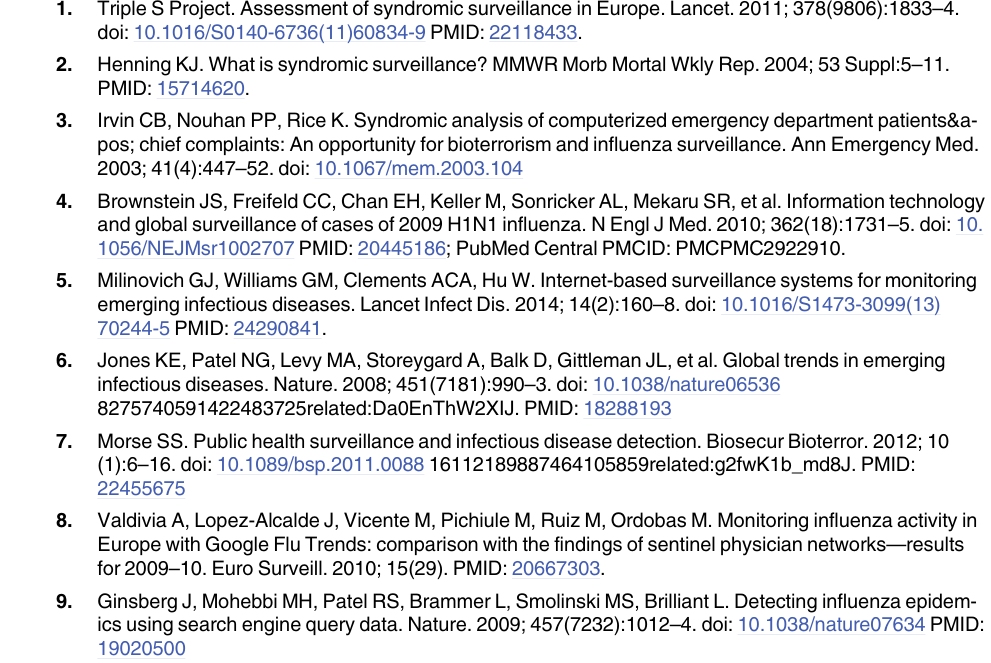
S1 Table. Lag correlation analysis (one week preceding of search query) between search query data and KCDC ILI. S2 Table. Lag correlation analysis (two weeks preceding of search query) between search query data and KCDC ILI. S3 Table. Lag correlation analysis (one week preceding of search query) between search query data and KCDC virologic data. S4 Table. Lag correlation analysis (two weeks preceding of search query) between search query data and KCDC virologic